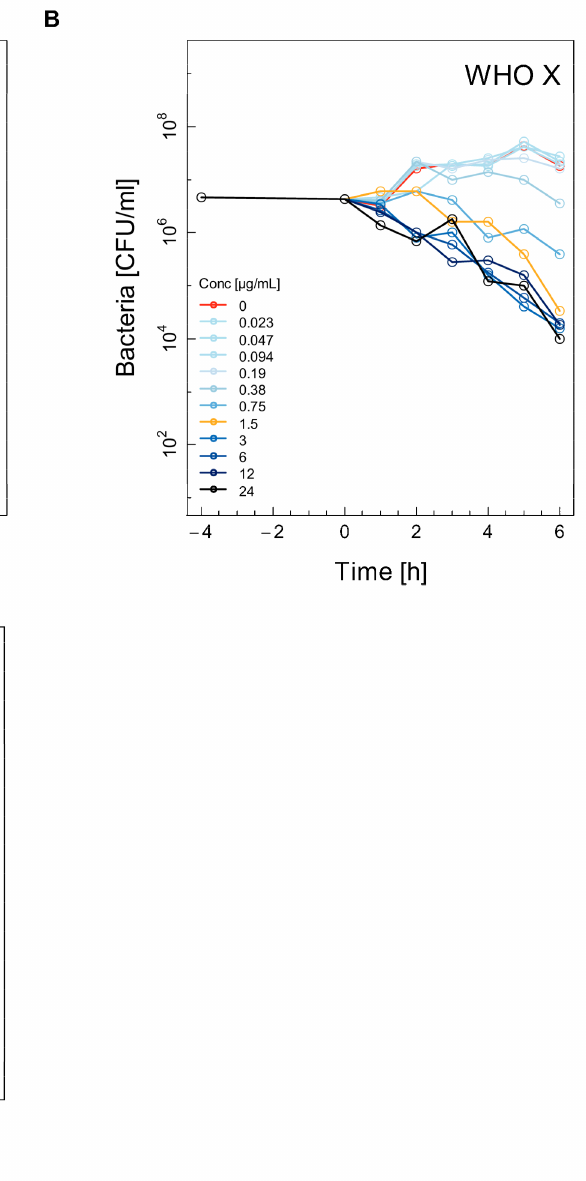
Figure 1. Selected time–kill curves (TKC) for three different strains of Neisseria gonorrhoeae using ceftriaxone. For each combination of antibiotic and strain, the TKC from one of the three independent experiments is shown: WHO F ( A ), WHO X ( B ), CS03307 ( C ). For each figure, eleven doubling dilutions are plotted. The black line corresponds to the highest concentration of antibiotics used in the assay (16 × the minimum inhibitory concentration (MIC)). The yellow line represents the concentration corresponding to 1 × MIC, while the red line represents growth in the absence of antimicrobials. The number of colony-forming units (CFU)/ml was measured from 4 h before until 6 h after the addition of antimicrobials. The limit of detection was 200